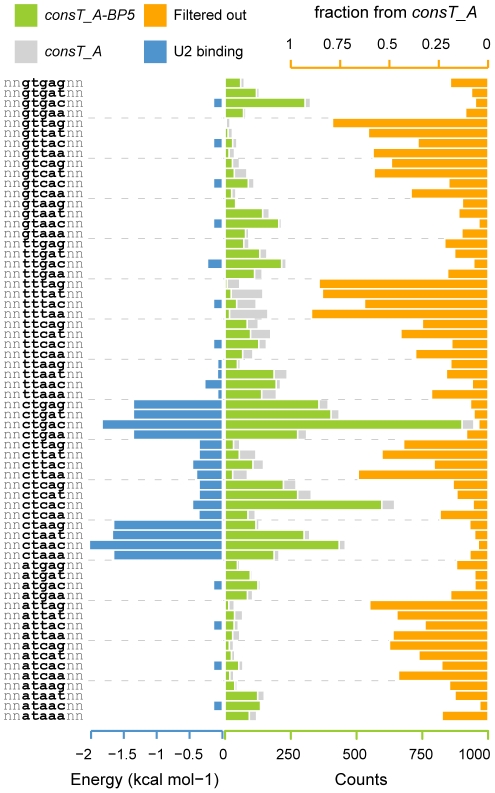
Sequence counts correlate with U2 binding energy.Barplot showing, for each nonamer cluster, the U2 binding energy (blue), number of occurrences in the consTNA and consTNA-BP5 sets (grey and green, respectively). The fraction of eliminated cases by the use of the 124 BP-associated pentamers is also shown in orange. Nonamer clusters were grouped by core pentamer (5 central positions).